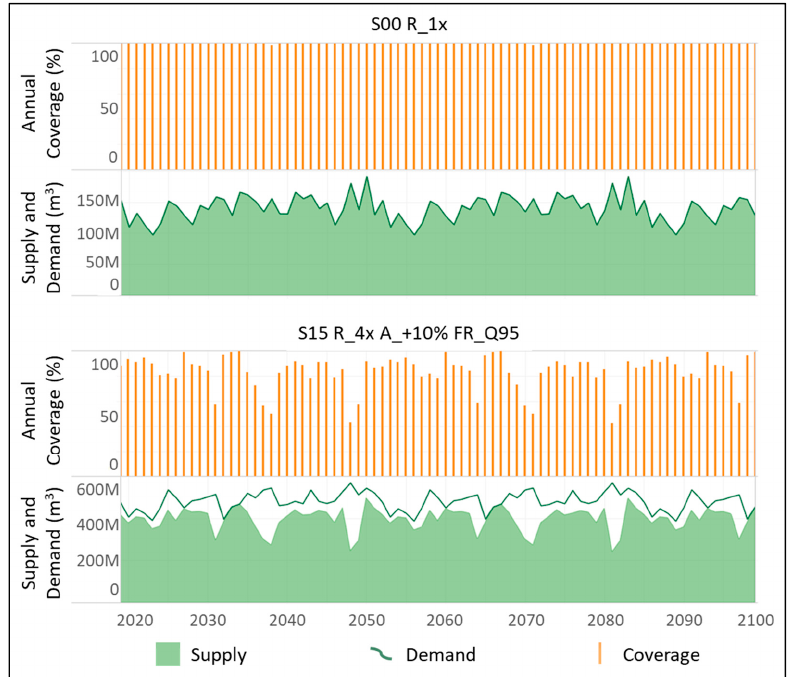
Figure 11. Annual coverage and comparison of annual rice irrigation demand (dark green line) and Annual coverage and comparison of annual rice irrigation demand supply (light green area) for S00 and S15, with historical climate. An interactive graphic with all (dark green line) and supply (light green area) for S00 and S15, with historical strategies and climate scenarios can be